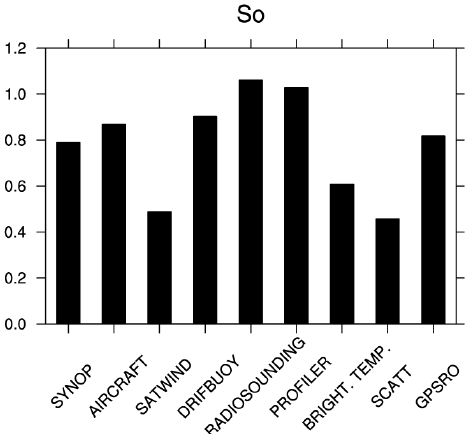
Fig. 6. Diagnosed σ o ’s-tuning factors per observation type (September 2013).